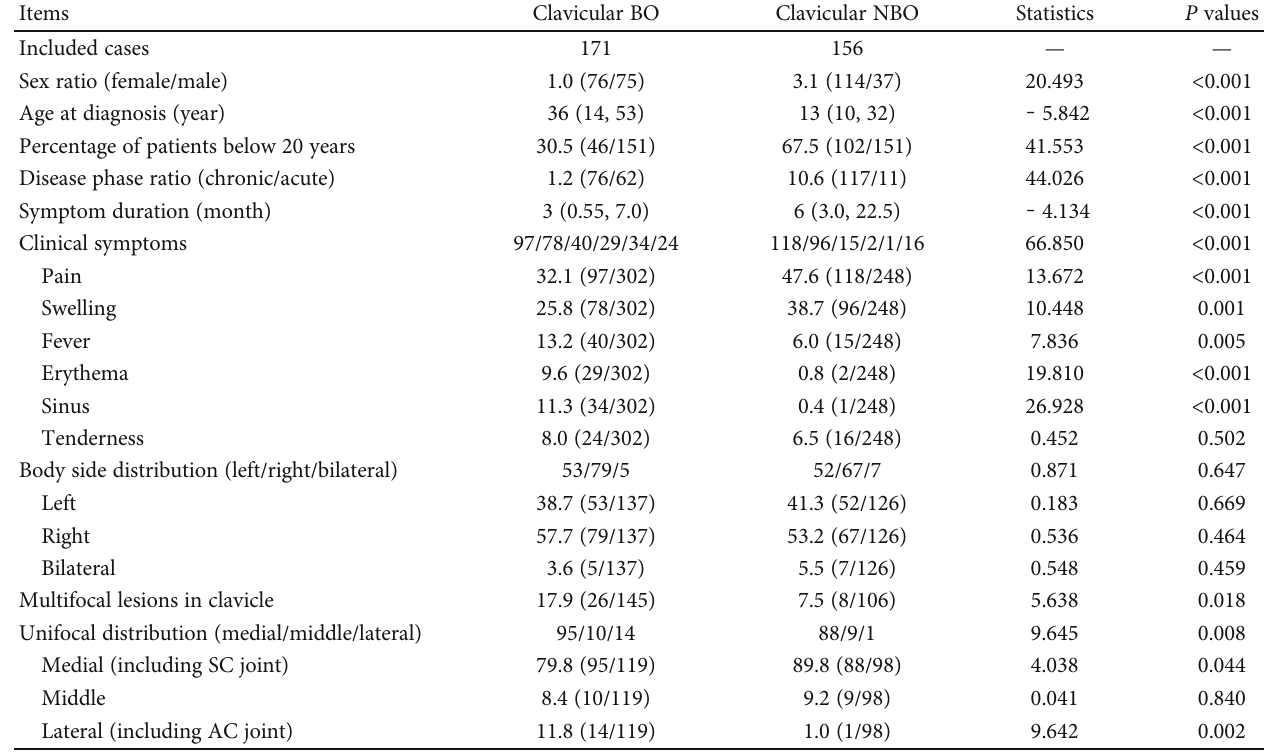
Table 1: Similarities and di ff erences of clinical characteristics between clavicular BO and NBO.